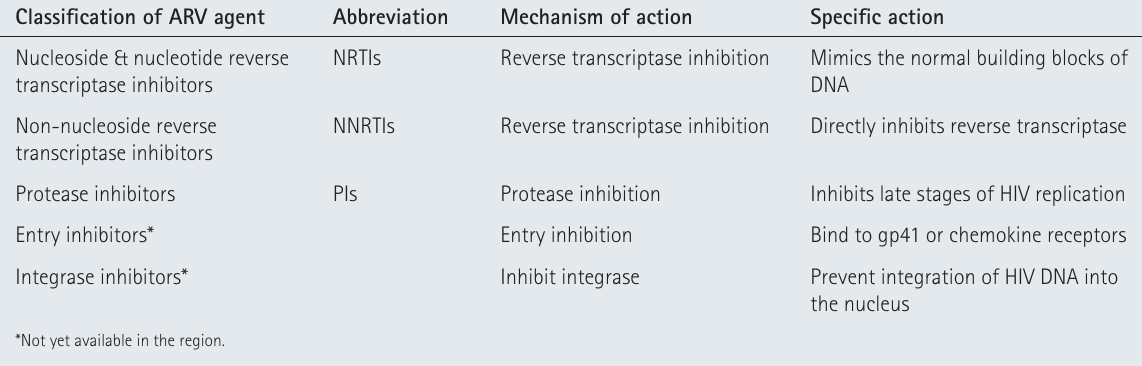
tAble i. clAsses of ARV AGeNts ANd theiR MechANisM of